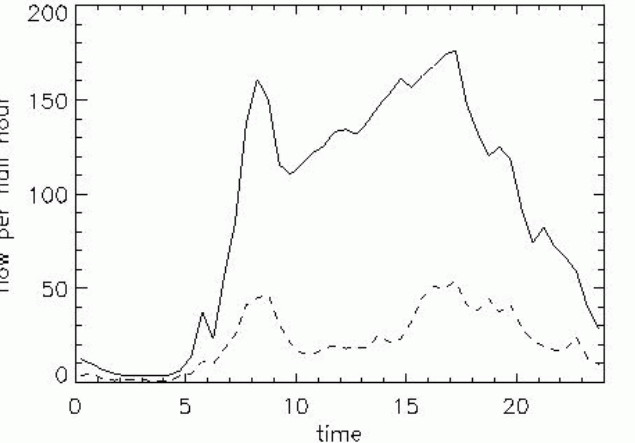
Figure 2. An example of an average volume profile for a cluster with normal profiles (solid line) and the average profile for a cluster with outlying volume profiles (dashed line) Clustering is one of the methods for outlier mining (Weijermars, 2007). In this paper we used another method, a 3-sigma clipping criterion. First, we defined the distance ∆ (R-S) between two profiles R and S as the root-mean-square (rms) of their differences per time